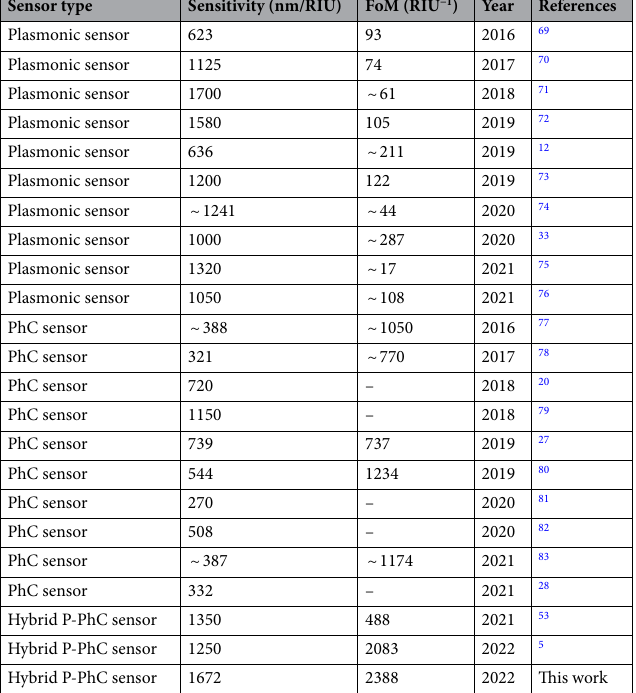
Table 2. Comparison of the sensing performance of the proposed hybrid PhC-P RI sensor with other RI sensors recently reported in the